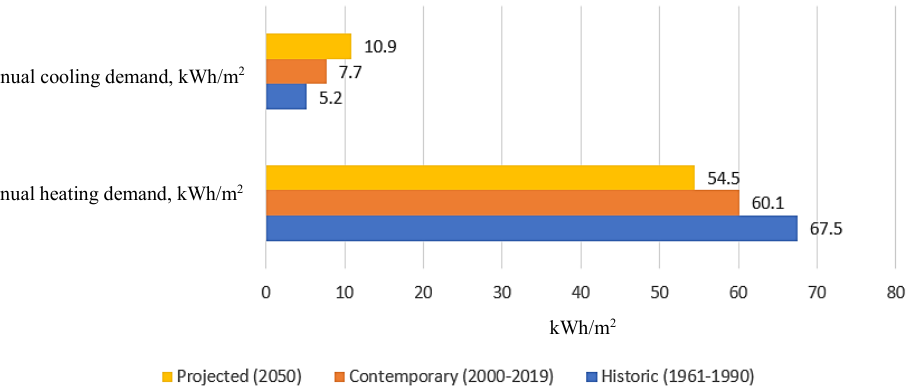
Fig. 7. Annual energy demand for space heating and cooling for the optimized model mapped out across varying climate